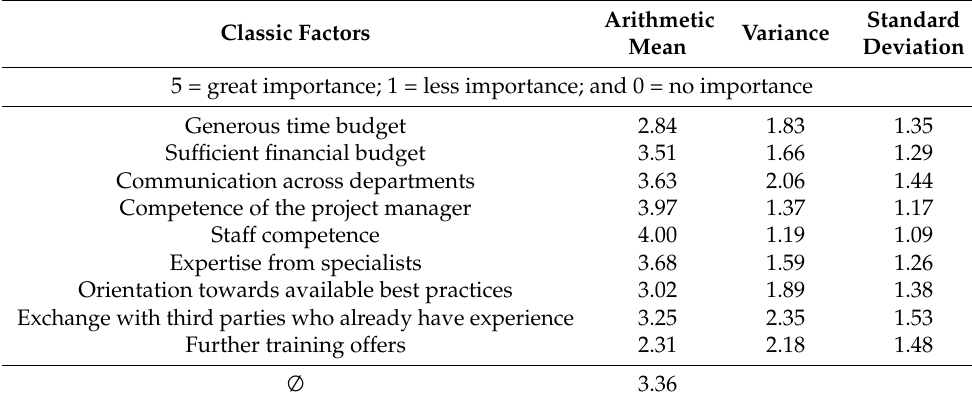
Table 2. Requested barriers in digitization projects ( n =